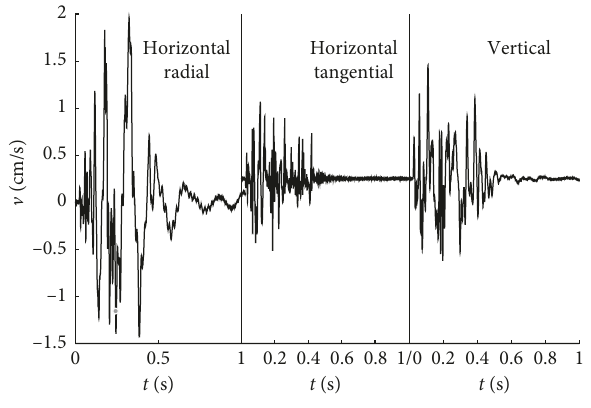
Figure 2: Typical signal of seismic wave.